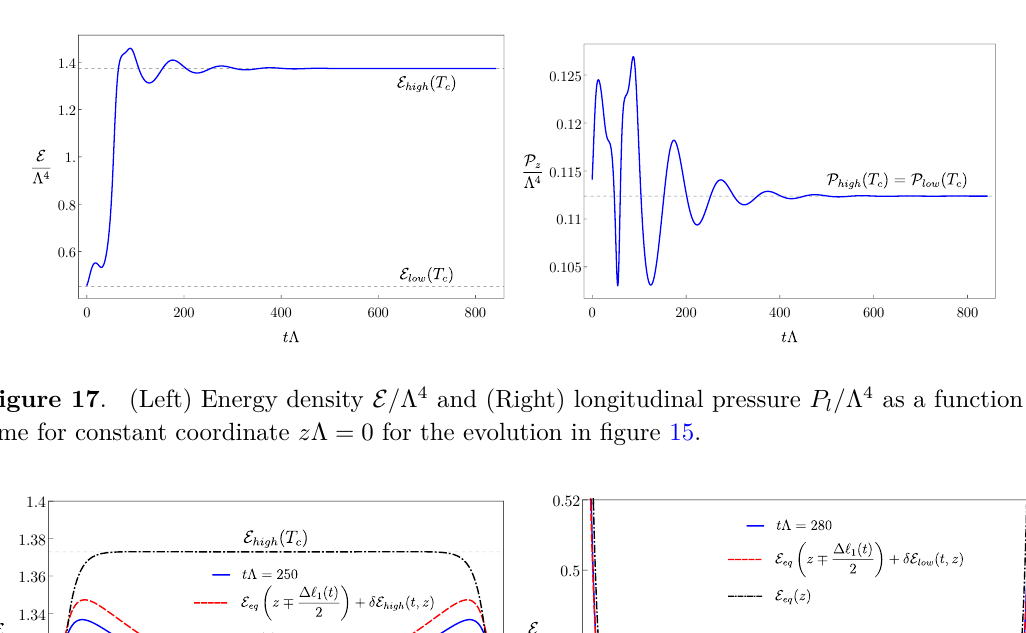
Figure 16 . Time evolution of the total entropy (per unit transverse area) for the evolution in figure 15. S 2 is the entropy of a static configuration with two domains (the dashed, red curve in figure 8). S 1 is the entropy of a static configuration with the same total energy but a single domain.